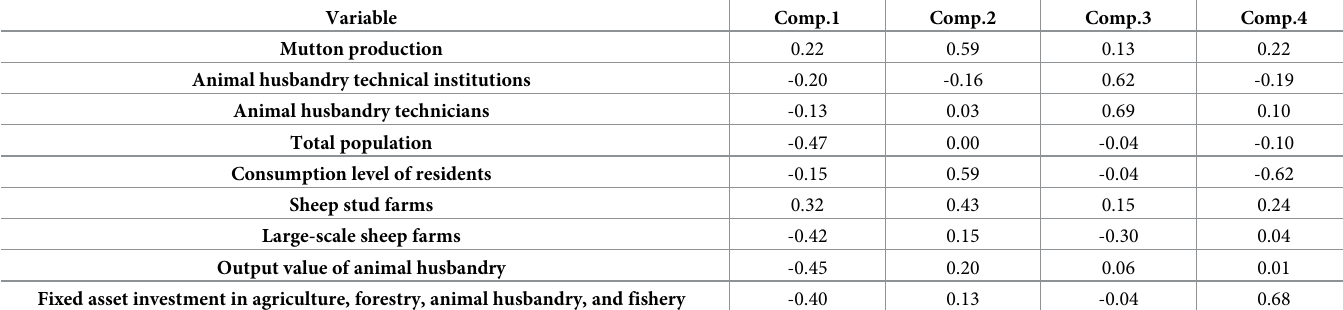
Table 3. Principal component analysis results corresponding to each